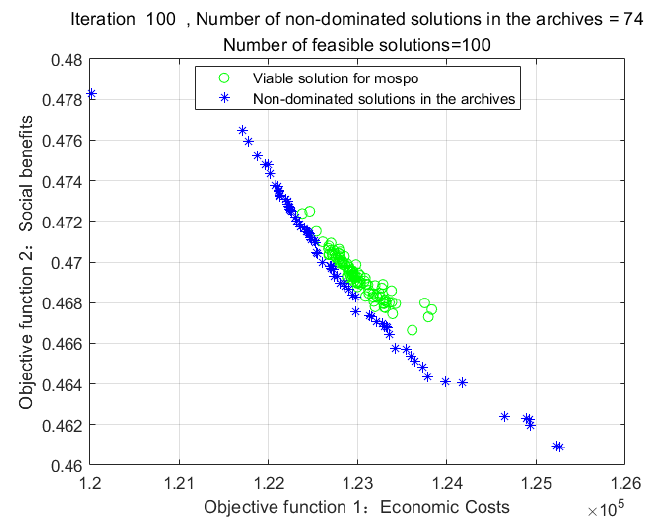
Figure 4. Iterative optimization of objective functions. Table 2. Comparison of water level combination data when meeting water and electricity demand.